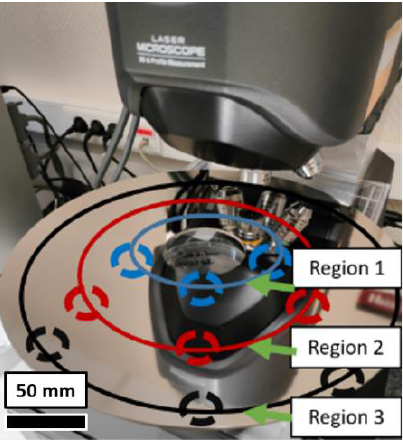
Figure 21. Photography of polished Nb disk with indicated regions which were analyzed with a laser confocal microscope. Note: polishing time 2 h.